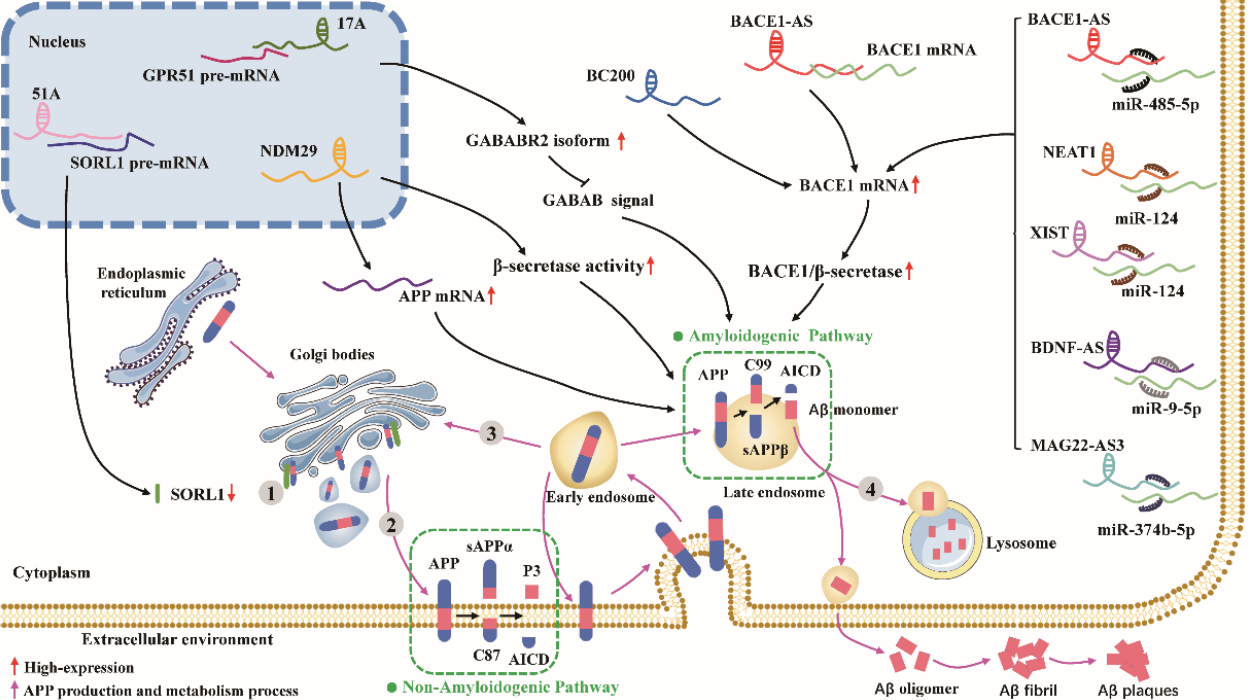
Figure 1. Schematic representation of regulatory mechanisms of lncRNAs during APP processing and A β production. lncRNAs are first produced in the endoplasmic reticulum, modified by Golgi processing, and transported to the plasma membrane, where they primarily enter the nonamyloid processing pathway (green box). lncRNAs are internalized from the plasma membrane to form early endonucleosomes, from where they: (1) Can be transported again to the plasma membrane to enter the recycling pathway, (2) Can be returned to the TGN via the reverse-transcriptase-mediated pathway, (3) Can form late intranucleosomes that enter the amyloid processing pathway (green box) or fuse with lysosomes for degradation; the above pathways are indicated by pink arrows. Grey circles marked with numbers 1–4 represent APP processing and A β production with the involvement of SORL1. lncRNAs regulate APP processing and A β production by a variety of specific mechanisms, including mRNA transcription (NDM29 and BC200), mRNA splicing (51A and 17A), miRNA sponges (BACE-AS, NEAT1, XIST, BDNF-AS, and MAG22-AS), mRNA stability (BACE1-AS), and protein activity